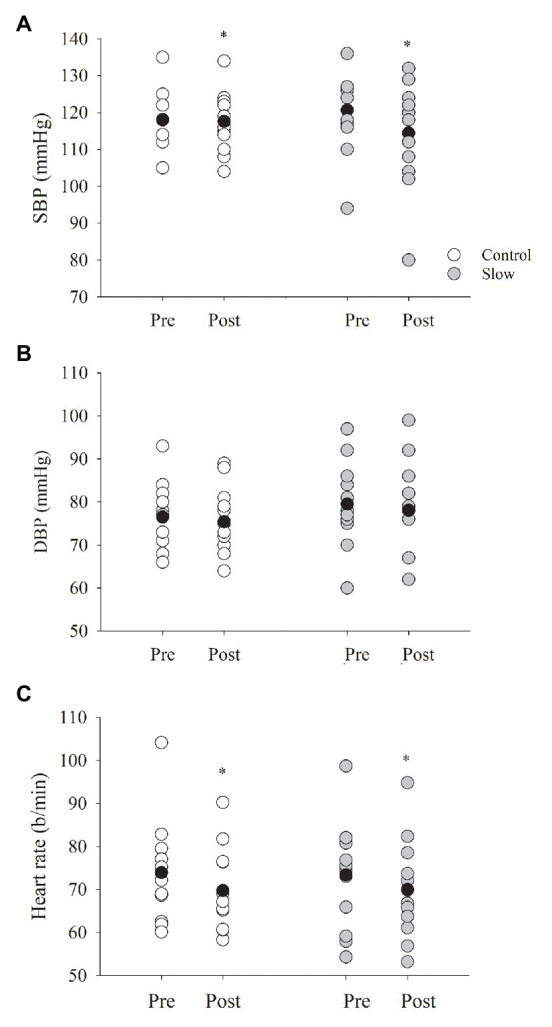
Blood pressure and heart rate (HR) before and after both breathing conditions. (A) Systolic blood pressure (SBP) decreased from pre- to post-test for both breathing conditions (p = 0.002), where diastolic blood pressure (B, DBP) did not (p = 0.44). (C) HR decreased following each breathing condition (p < 0.001). Black circles indicate average data, *significant difference.